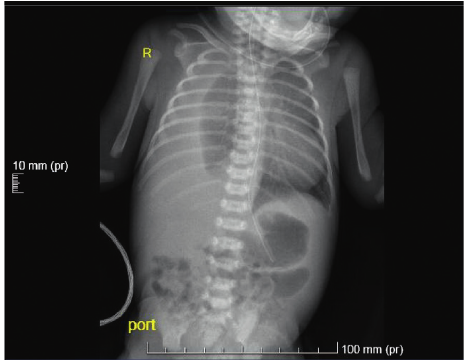
Figure 1: Initial chest X-ray showing right-sided pleural effusion. Table 1: Pleural fluid